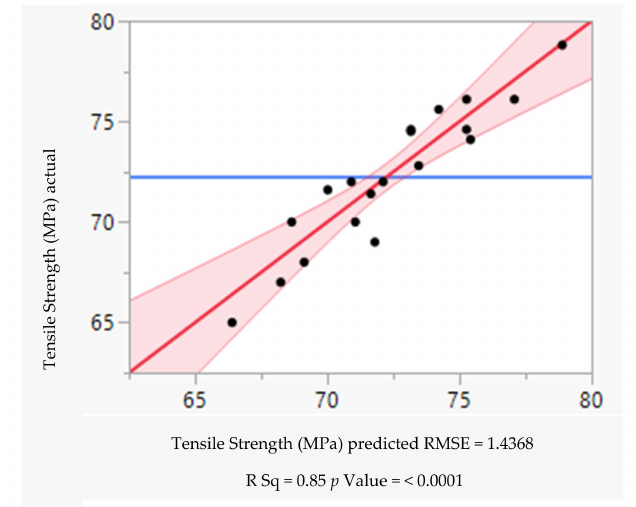
Figure 12. Actual tensile strength vs. predicted